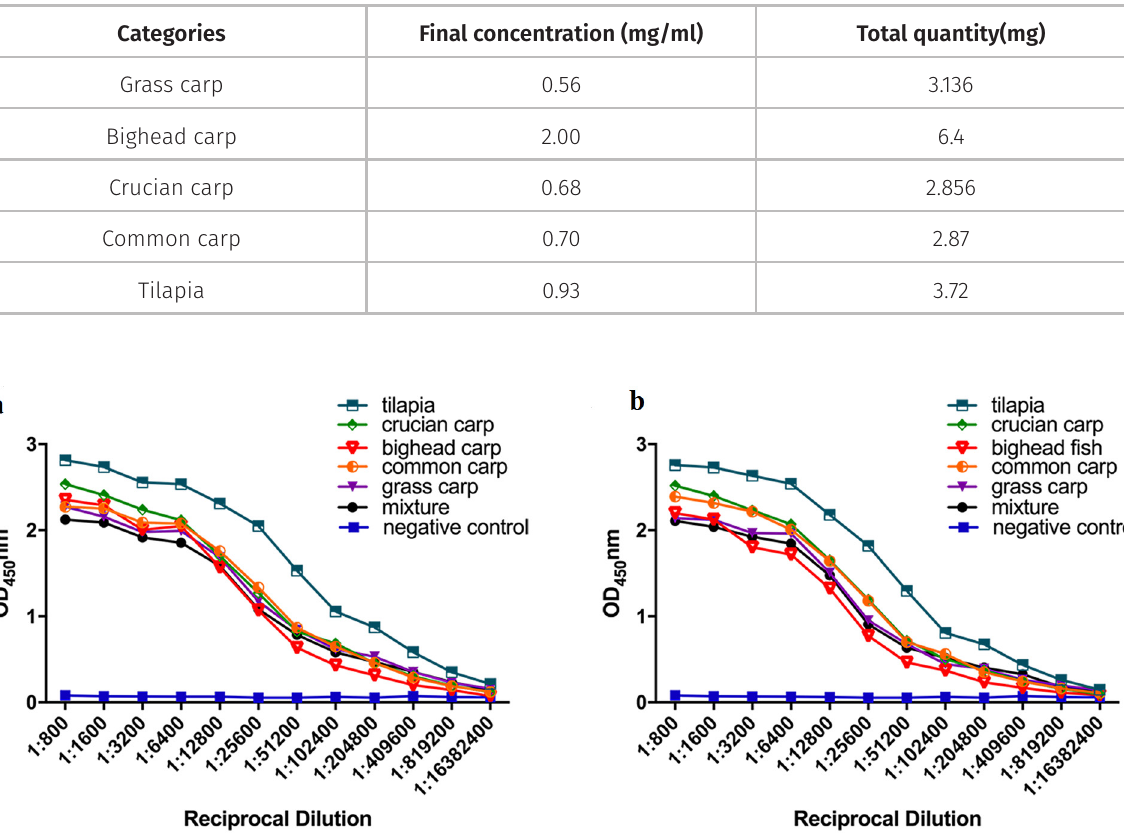
Figure 2. Antibody titers in sera from rabbits immunized with purified fish IgM by ELISA. Sera were collected 6 weeks (a) and 7 weeks (b) after the first immunization. Antibody titers of IgG induced by purified IgM from tilapia, crucian carp, bighead carp, common carp, grass carp or mixed IgM of the five categories (mixture) were assayed. Negative control denoted serum from preimmunized